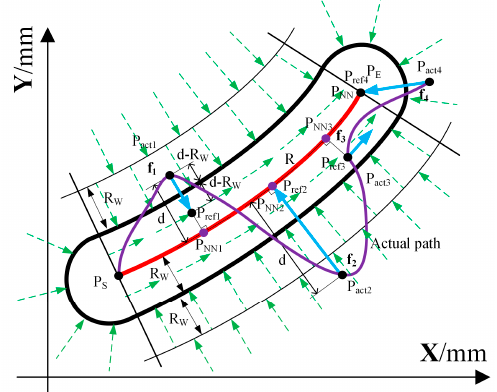
Figure 5. Concept of the virtual tunnel in the assist-as-needed (AAN) control (simplified to a planar case for better understanding).